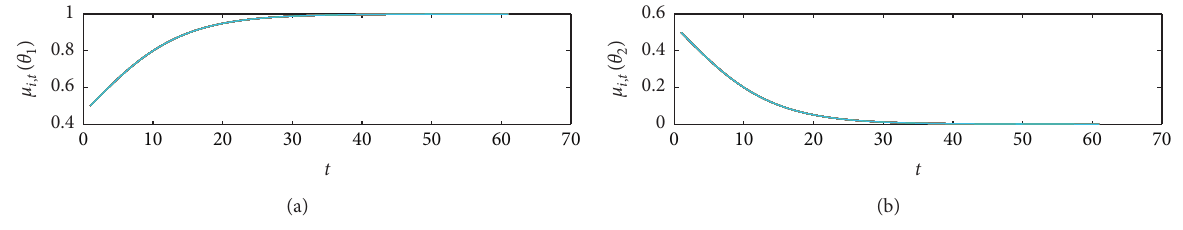
Figure 3: Bayesian social learning results. Table 1: Comparison of average consensus